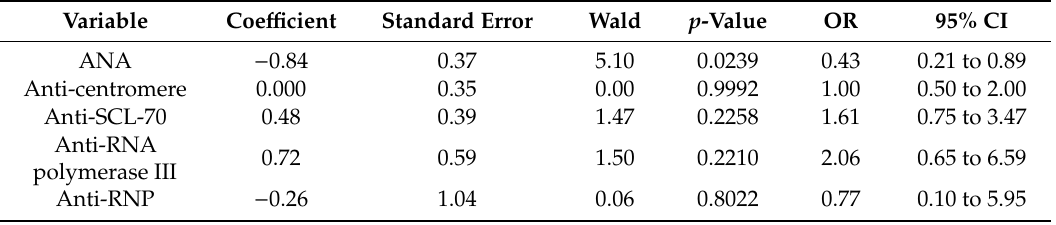
The risk of psoriasis in SSc patients according to the positivity of auto-antibodies (multivariate logistic regression with adjustment for age, gender, body mass index, smoking status and socioeconomic